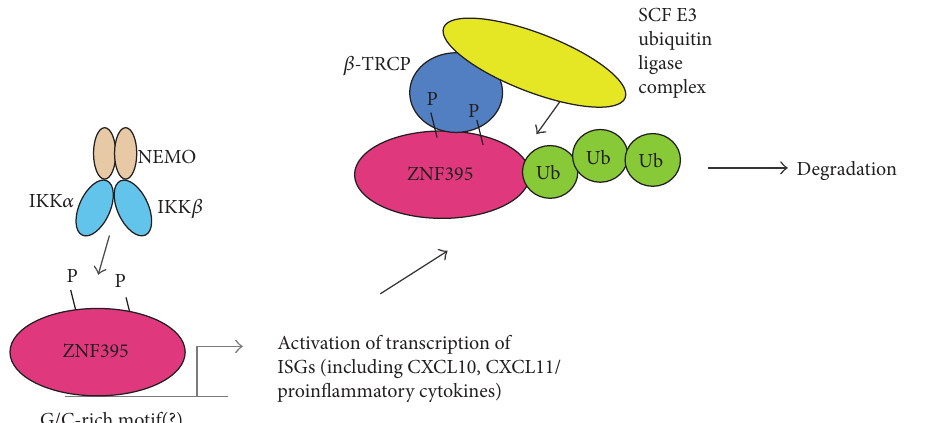
Figure 7: Schematic illustration of the regulation of ZNF395 within the immune response. Active IKK phosphorylates ZNF395, which allows ZNF395 to activate transcription of immune response involved genes. Phosphorylated ZNF395 is a target of the F-box protein 𝛽 -TRCP, which is a subunit of the E3 ubiquitin ligase, the SCF (Skp1-Cullin-F-box) complex. 𝛽 -TRCP directs the conjugation of ubiquitin to ZNF395 leading to its proteasomal degradation, thus keeping the transcriptional activity of ZNF395